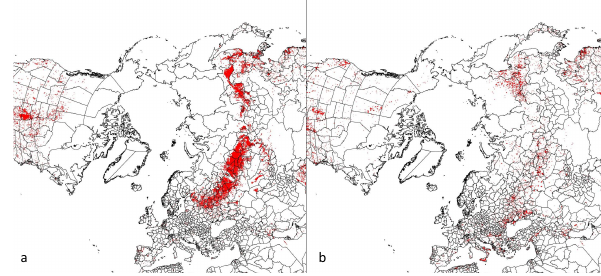
Fig. 4. Plot of the MODIS fire counts in the Northern Hemisphere during (a) April 2008 and (b) June–July 2008.